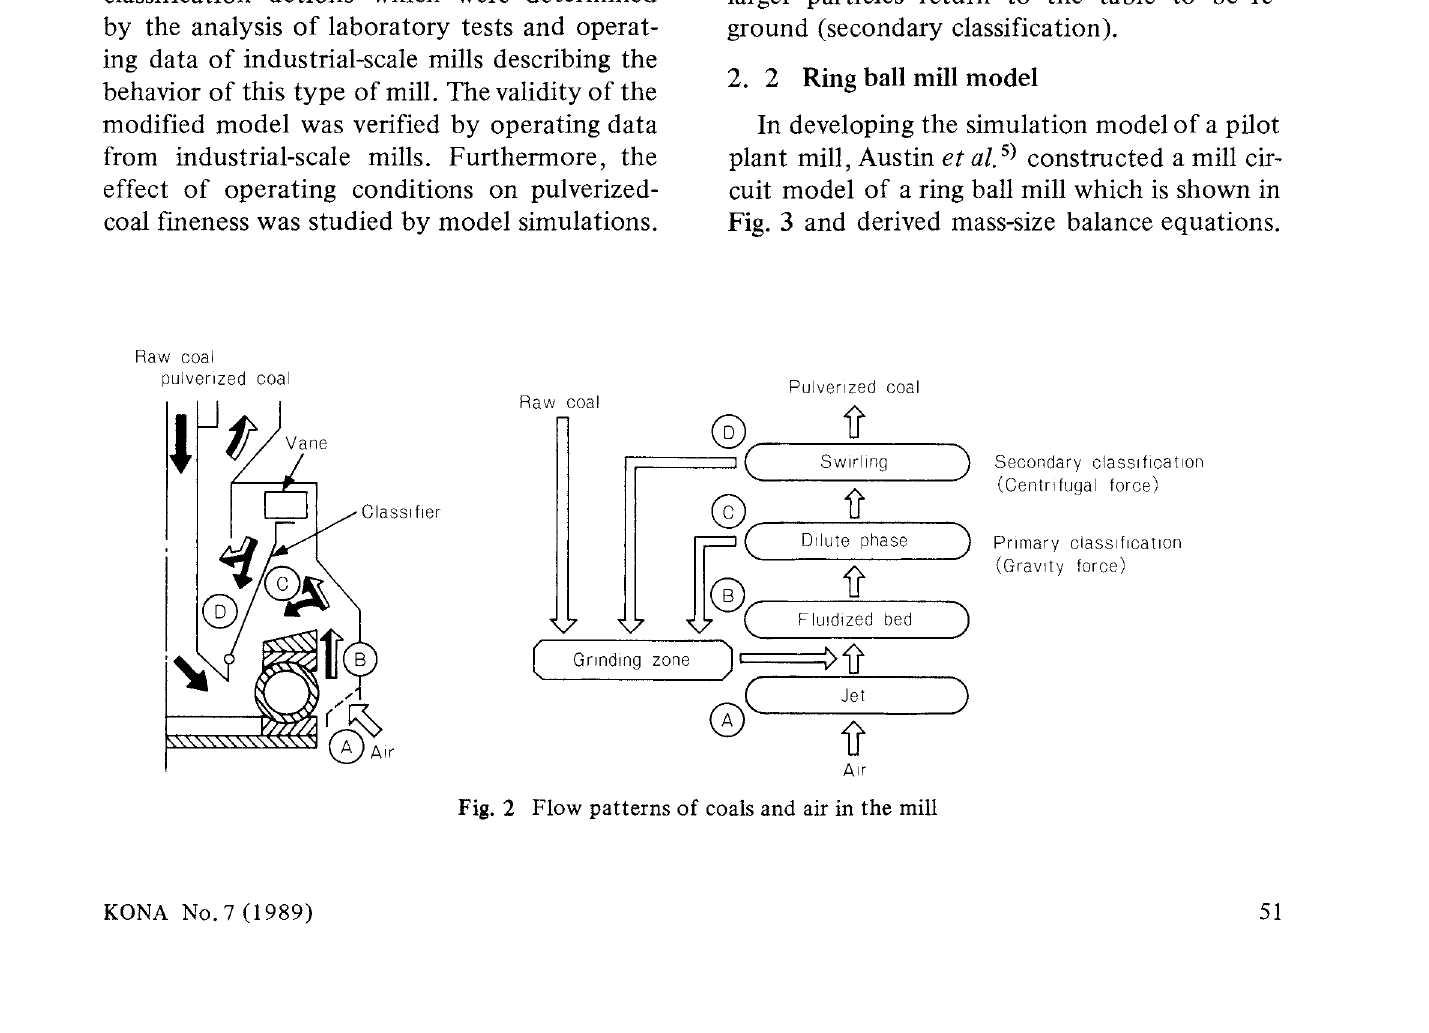
Fig. 3 and derived mass-size balance equations.